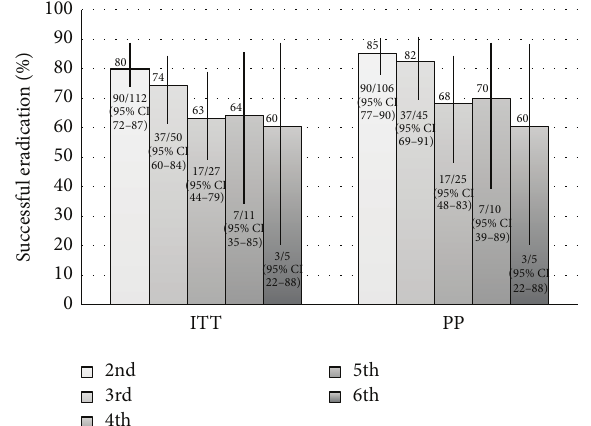
Figure 4: Eradication as per treatment attempt. ITT: intention to treat analysis, PP: per protocol analysis.